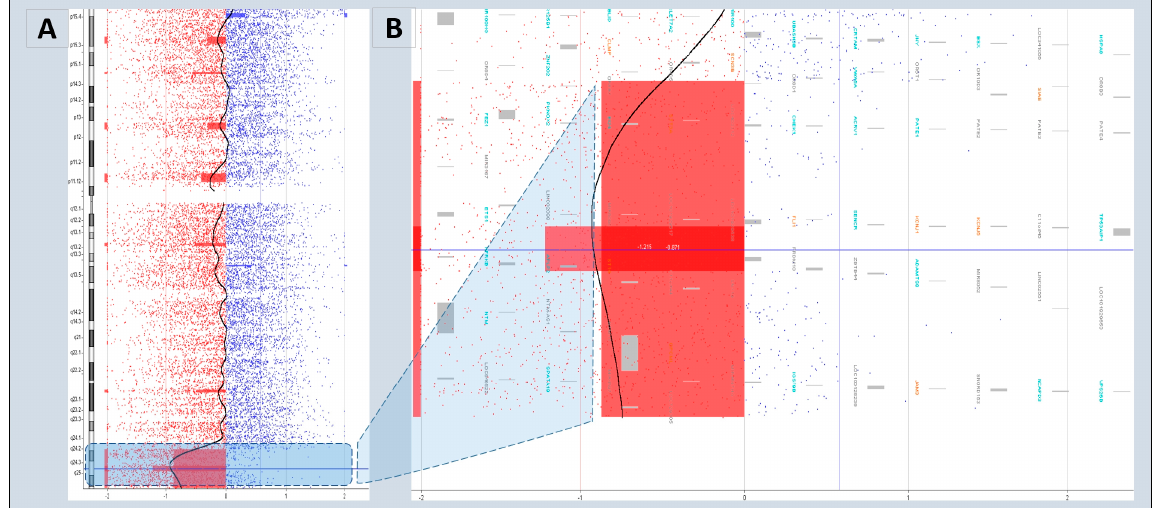
Figure 2. ( A ) Chromosomal microarray analysis showing 10.8 Mb subtelomeric deletions of chromo- some 11q24.2q25 in a 4-year-old male [BL-080-12] patient with developmental delay, delayed speech, and dysmorphic features. ( B ) Detected region of chr11: 123,615,752-134,432,324bp encompasses many pathogenic genes, including FLI1 , KCNJ1 , KCNJ5 , ETS1 , and JAM3 that cause Jacobsen syndrome. A 4-month-old [BL-461-12] with DD, dysmorphic features, short stature, failure to thrive, small finger with two phalanges, and a simian crease in left hand harbored a 13q21.1q32.1 deletion. Deletion of the chromosome 15 q arm (15q13.1q26.1, 62.6 Mb) was detected in a 2-year-old [BL-363-12] with DD, speech delay, and dysmorphic features. A deletion and duplication of the chromosome 16 p arm (16p13.3p11.2, 32.6 Mb) was detected in a 2-year-old [BL-363-12] with DD, speech delay, and dysmorphic features, and in a 6-year-old [BL-210-12] with DD and delayed speech, respectively. Another deletion and duplication of 16q21q23.1 were detected in a 1-year-old [BL-161-14] with DD, VSD, and failure to thrive, and a 2-year-old [BL-210-12] with DD, delayed speech, and dysmorphic feature, respectively. A 1-month-old [BL-597-12] with dysmorphic features, low-set ears, and closed VSD and a 16-year-old [BL-902-10] with DD, microcephaly, ID, and dysmorphic features had 18p11.32-p11.21 duplication. Duplication of 18q23 was found in a 1.5-year- old [BL-464-12] with DD and short stature (Figure 3). A deletion of 20q11.1q13.2 was found in a 2-year-old [BL-363-12] with DD, speech delay, and dysmorphic features. A duplication of 22q11.1-q13.33 was found in a 6-year-old [BL-210-12] with DD and speech delay; a deletion of 22q11.21 was present in a 3-month-old [BL-793-13] with DD,